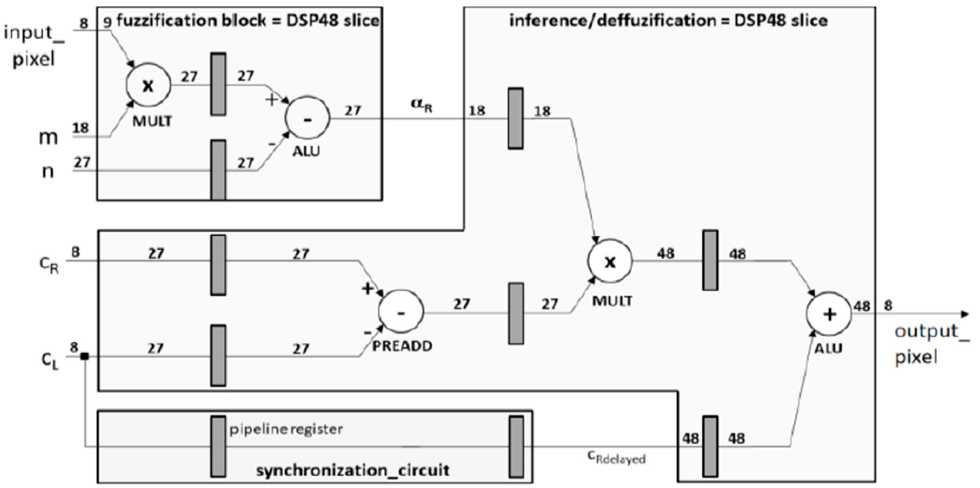
Figure 11. Fuzzy core block main structure [44] (Reprinted with permission from ref. [44]. Copyright 2021